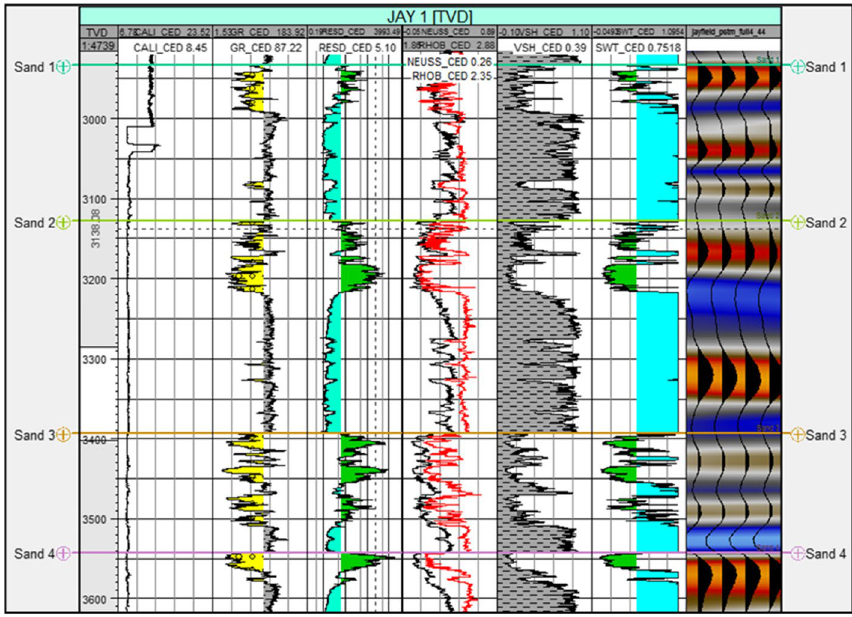
Fig. 11 The hydrocarbon-bearing reservoirs identified on well Jay